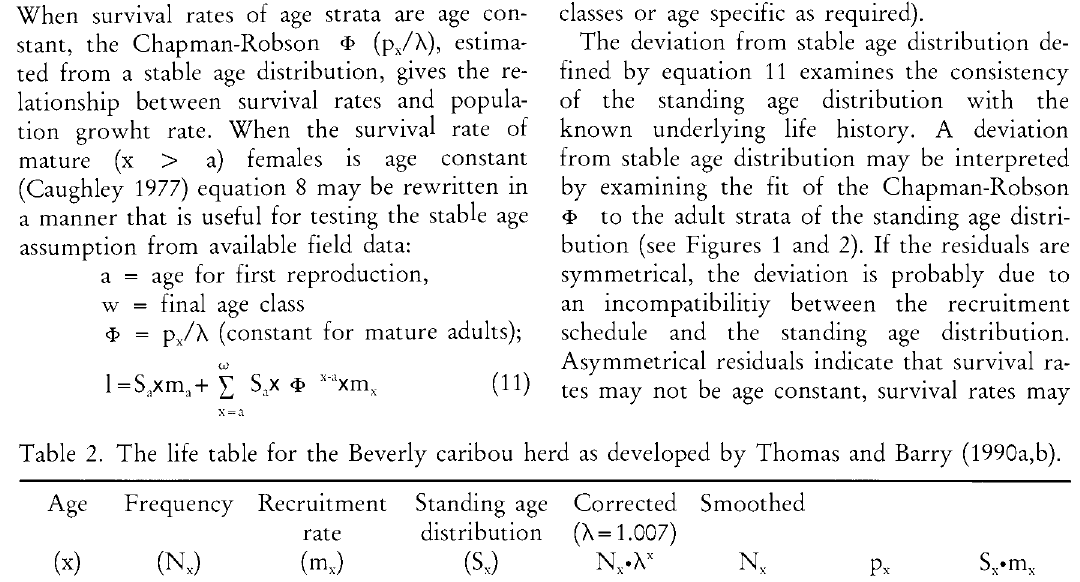
Table 2. The life table for the Beverly caribou herd as developed by Thomas and Barry